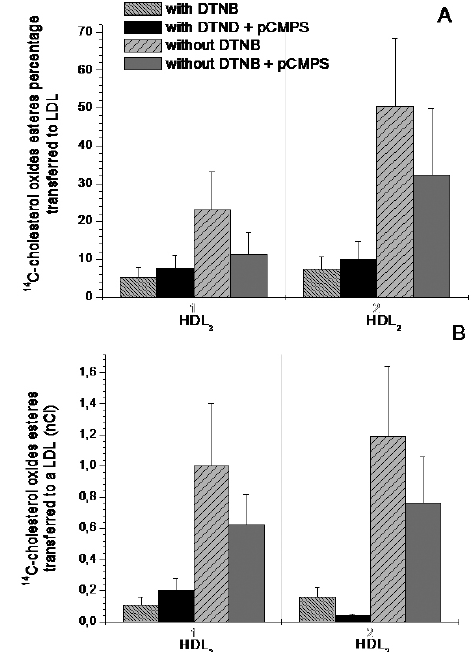
FIGURE 3 - Transfer of 14 C-cholesterol oxide esters from HDL and HDL to LDL, (A) in % of 14 C-cholesterol transferred and 2 (B) in nCi. Both with DTNB (LCAT inhibitor), with DTNB plus pCMPS (CETP inhibitor) , without DTNB and, without DTNB plus pCMPS.